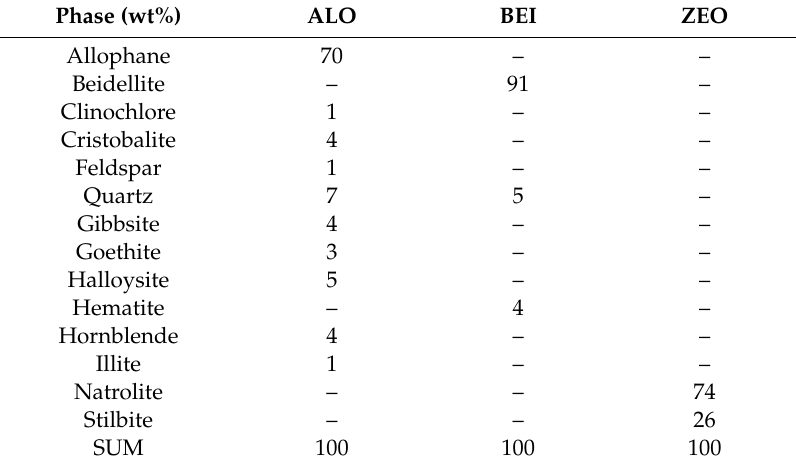
Table 1. Mineralogical composition of ALO, BEI and ZEO used as